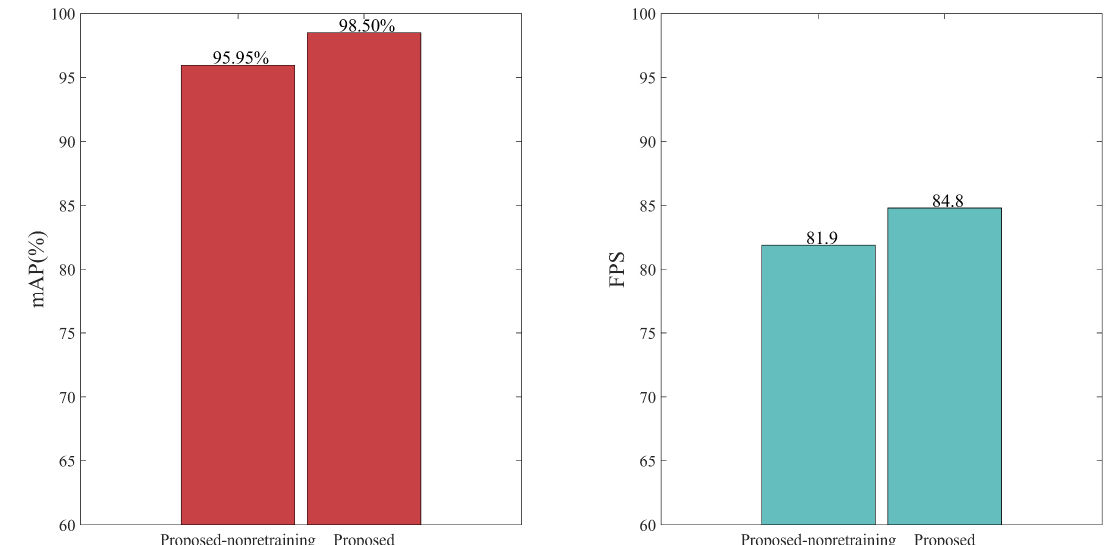
Figure 14. The impact of pre-training on the model.